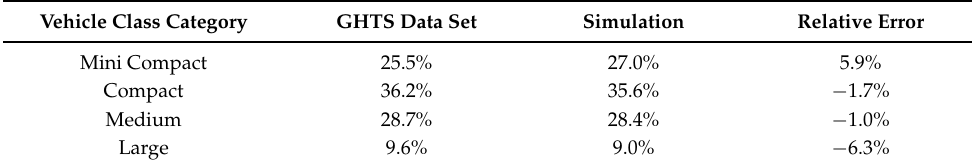
Table 4. Comparison of the simulation and the GHTS data set—vehicle class category distribution.